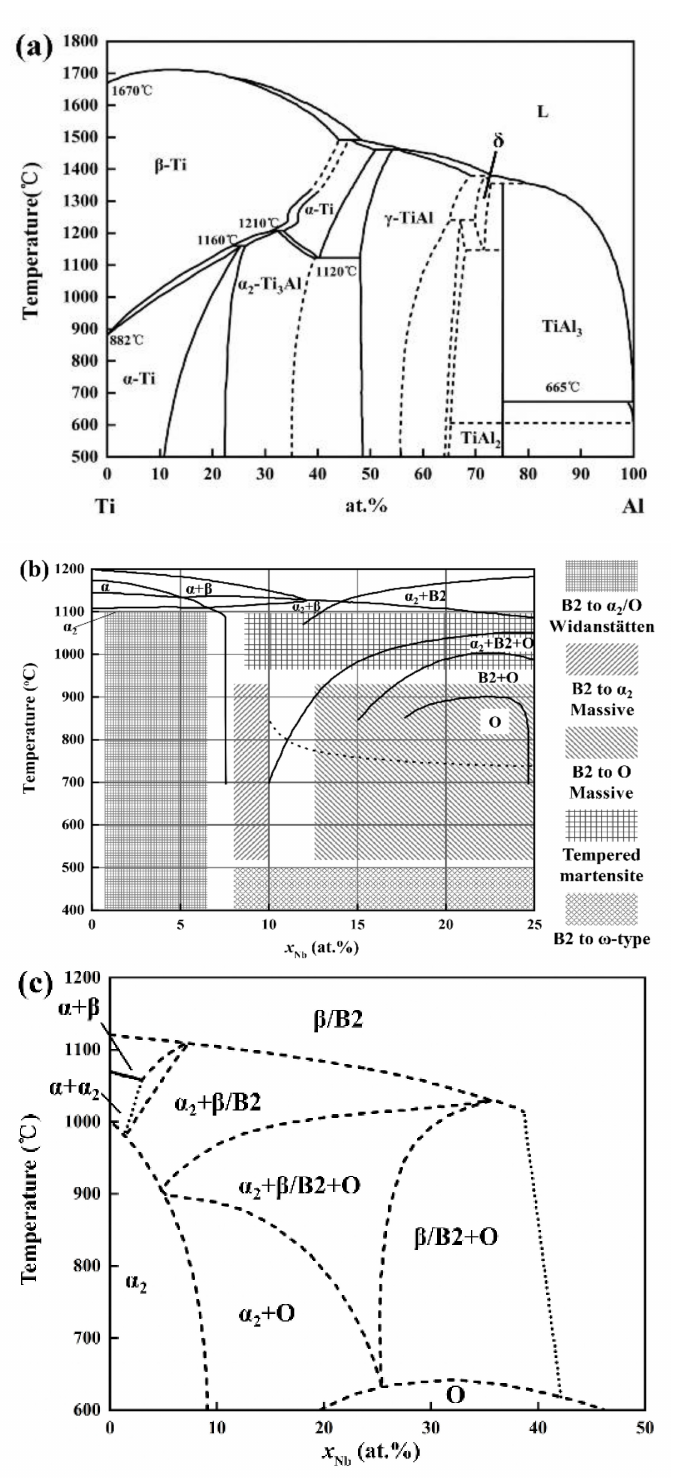
Figure 11. Phase diagrams used in this study: ( a ) Ti-Al binary phase diagram [17]; ( b ) Ti 3 Al- x Nb pseudo-binary diagram [18]; and ( c ) Ti-22Al- x Nb pseudo-binary diagram